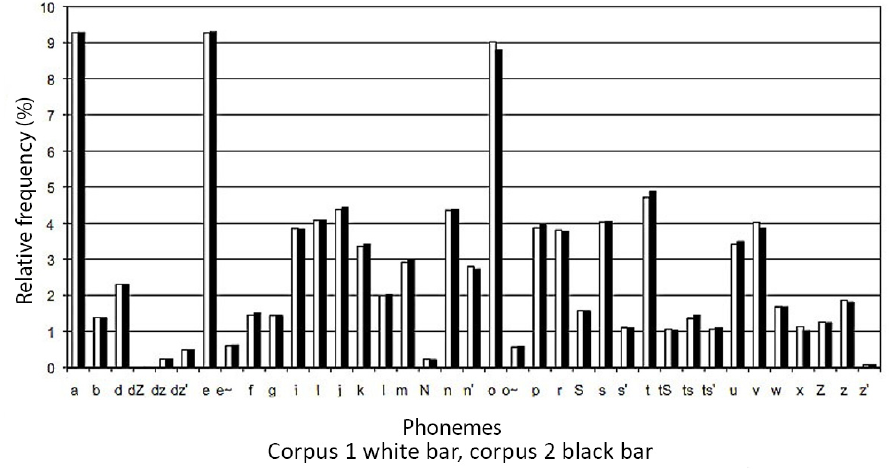
Figure 1. A comparison of frequency distribution of phonemes in two random parliamentary sub- corpora.